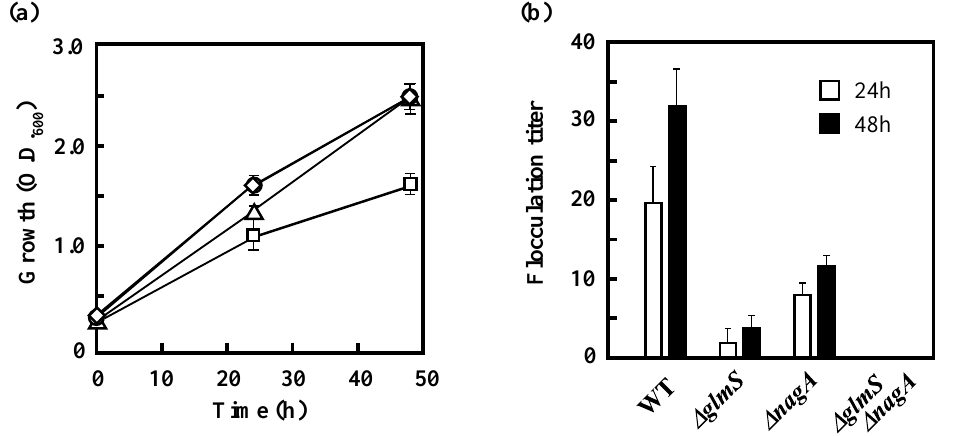
Figure 5. Growth of C. freundii IFO 13545 and its glmS, nagA, and glmSnagA disruptants ( Δ glmS , Δ nagA , and Δ glmS Δ nagA ) on acetate ( a ); and their flocculation activities ( b ). Symbols: circles, IFO 13545 (wild type, WT); triangles, Δ glmS ; diamonds, Δ nagA ; squares, Δ glmS Δ nagA . This experiment was conducted in triplicate; the averages ± standard deviations of the values obtained are shown.